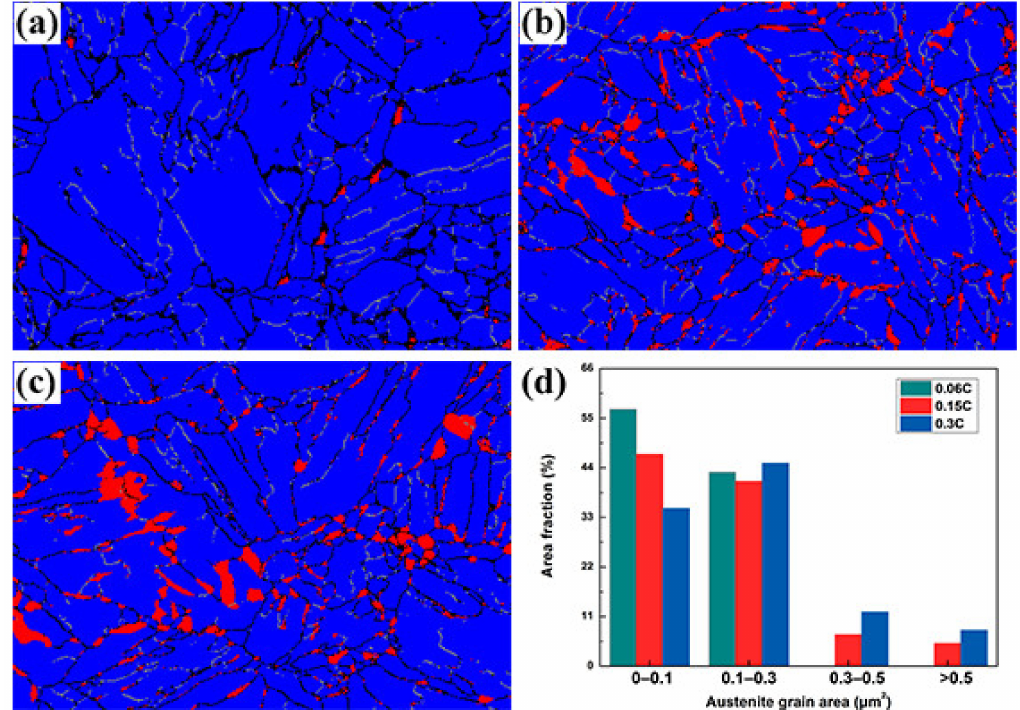
Figure 3. Electron backscatter diffraction (EBSD) phase maps and grain area distribution of austenite of samples. ( a ) 0.06C steel. ( b ) 0.15C steel. ( c ) 0.3C steel. ( d ) The grain area distribution of austenite in different